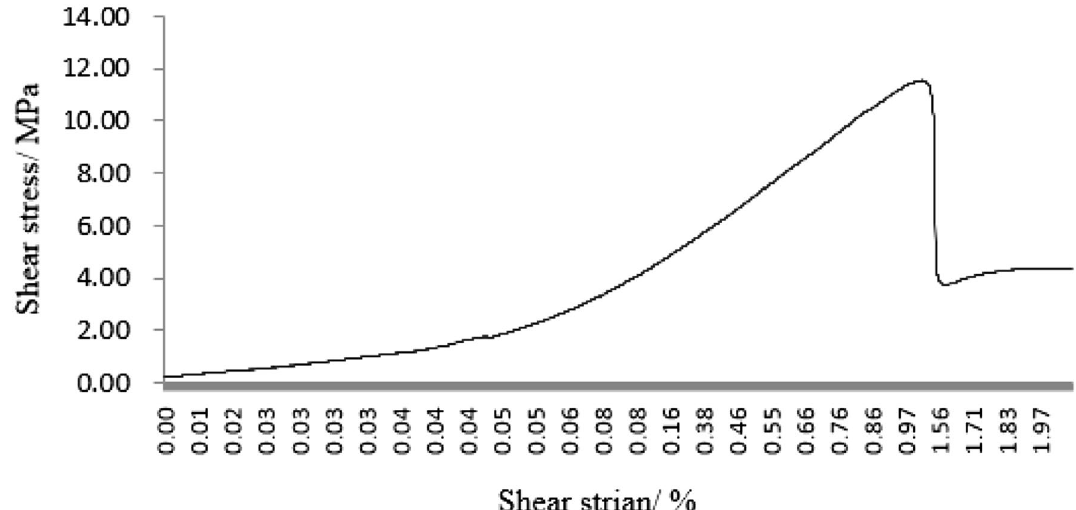
Figure 34. The fourth fracture mode rock shear stress-shear strain curve.